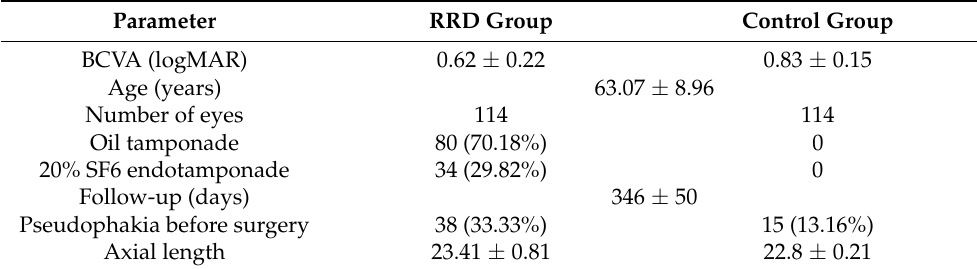
Table 1. Characteristics of RRD group and control